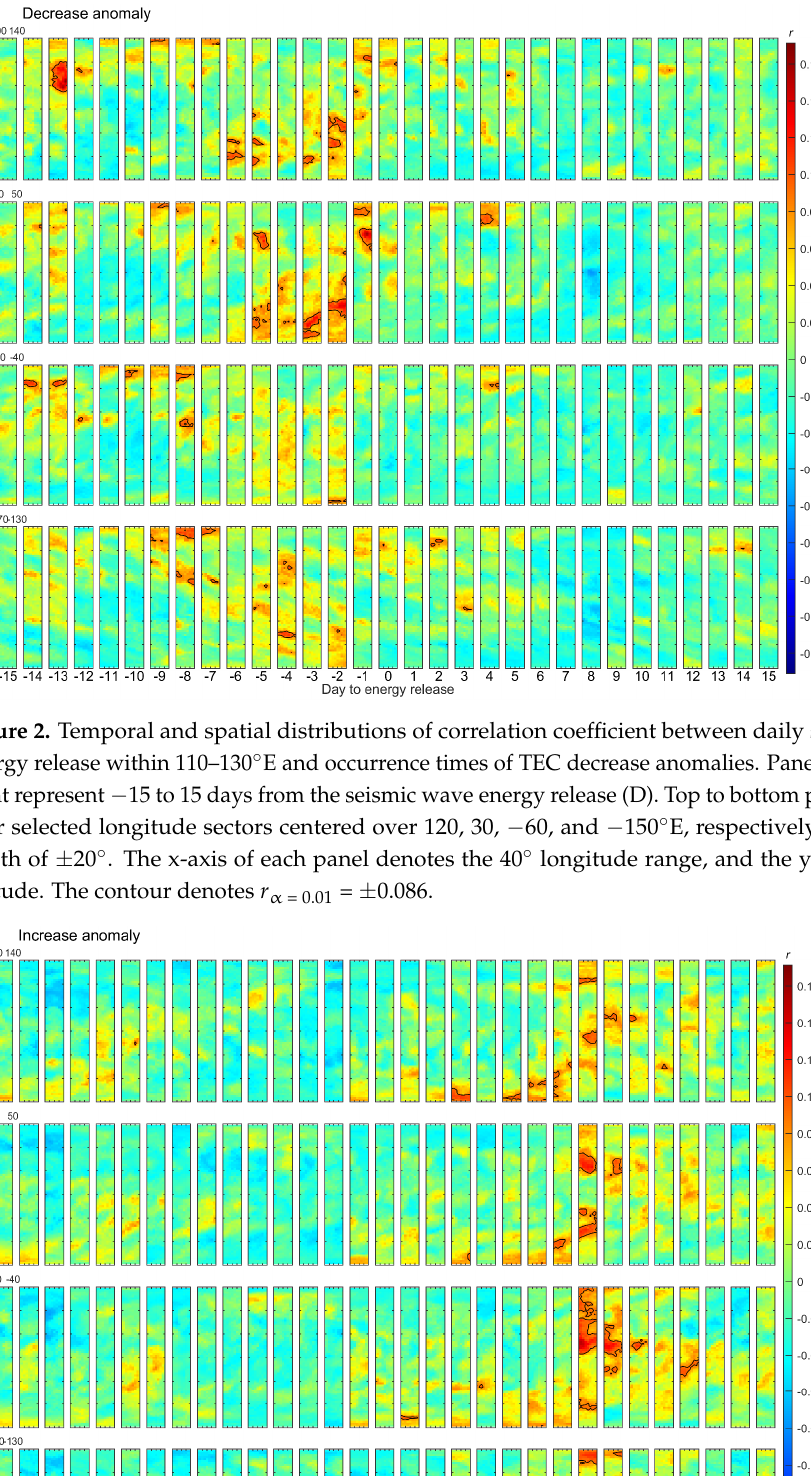
Figure 4. Same as Figure 2 for the results of occurrence times of both the TEC increase and decrease anomalies counted together.